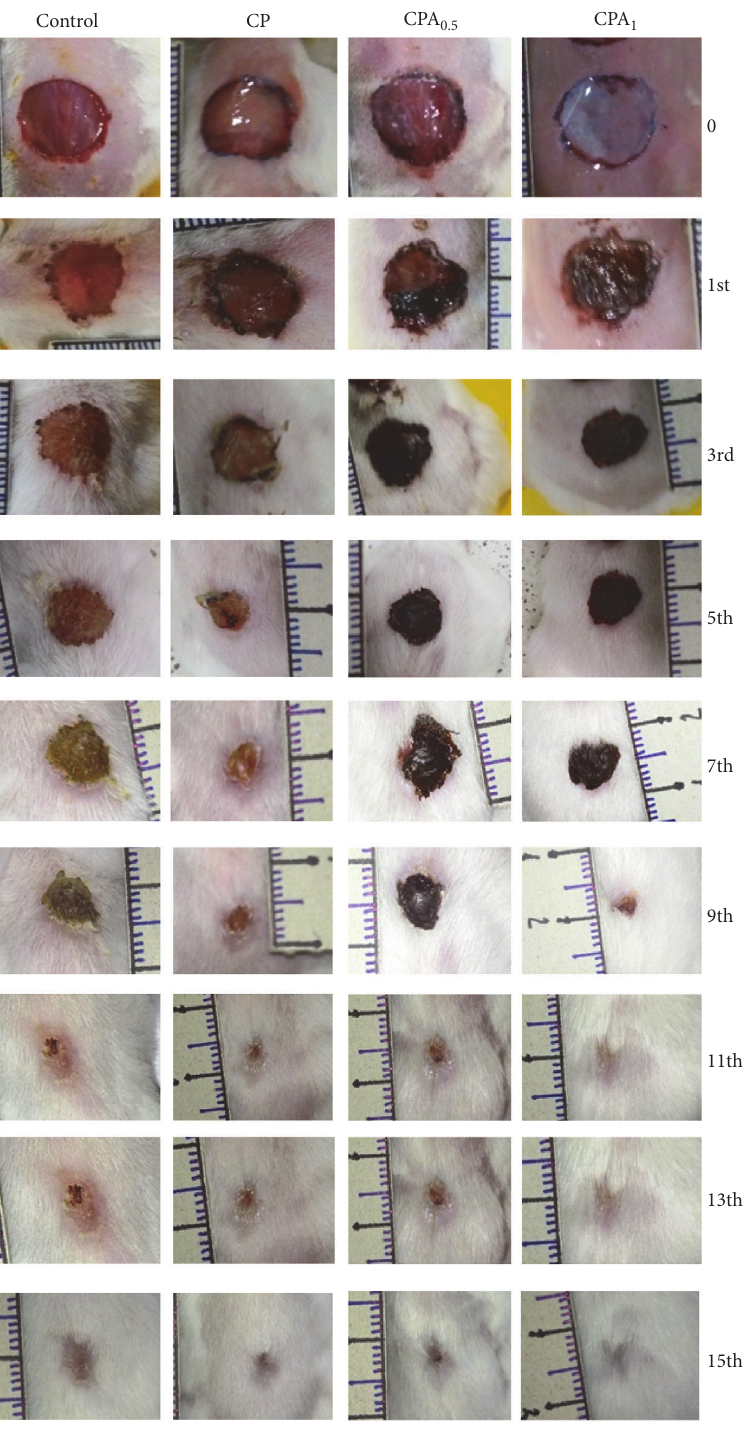
Figure 9: Photos of wounds treated with CP, CPA 0.5 , and CPA 1